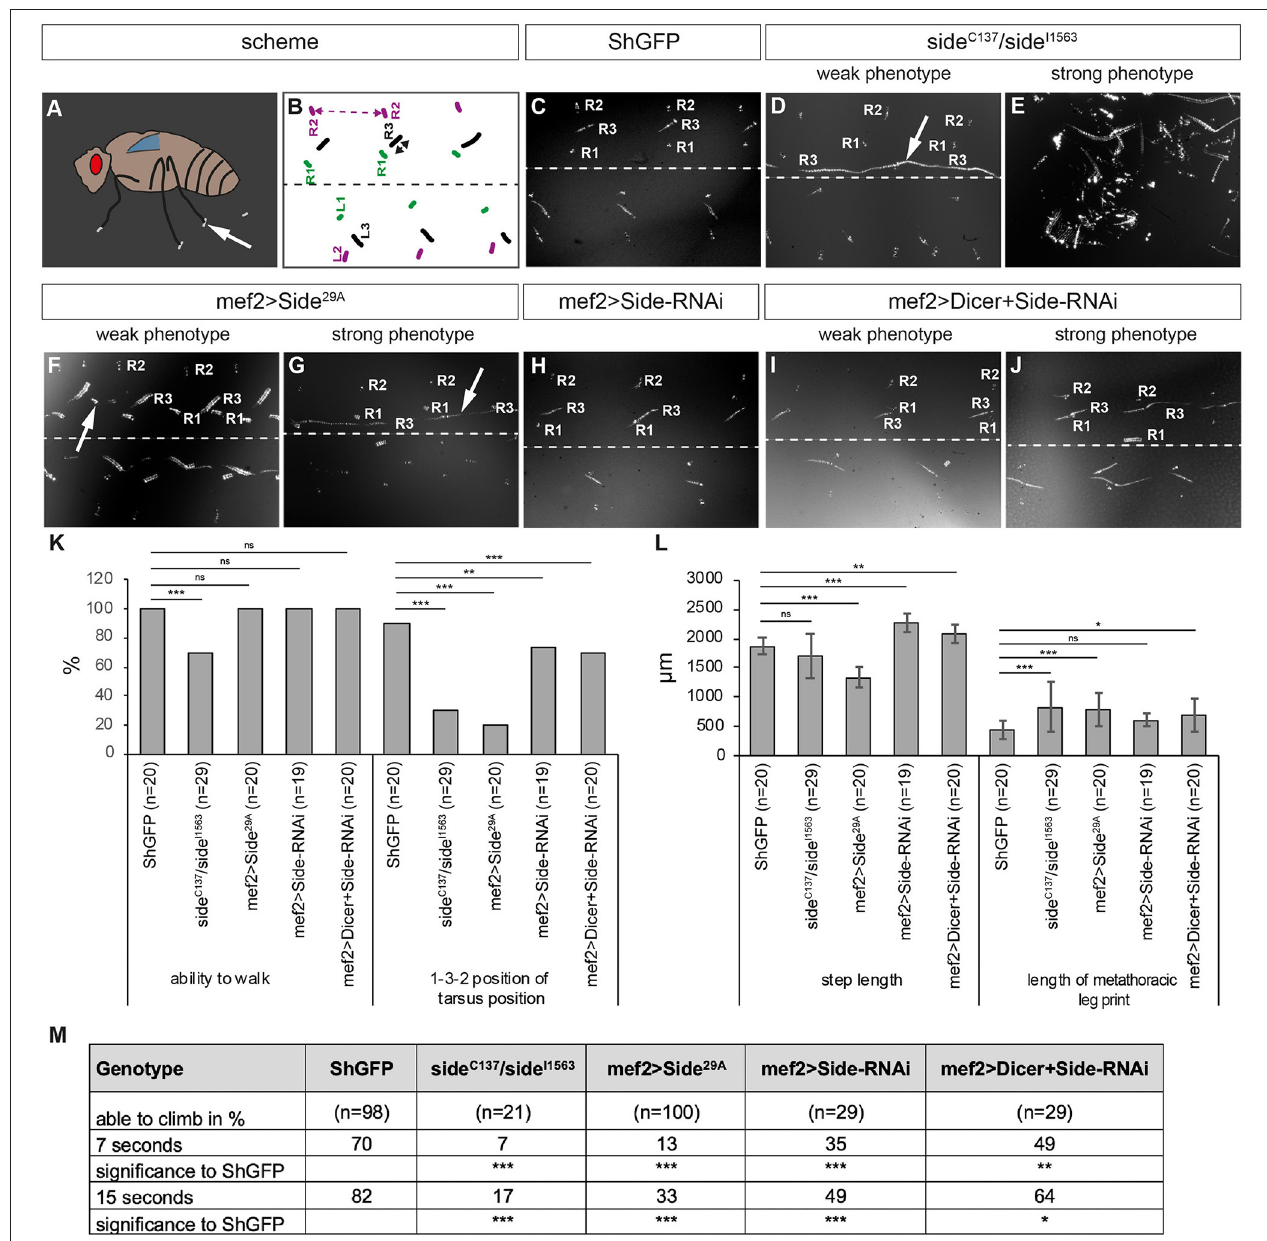
FIGURE 3 | Misinnervation of leg muscles strongly alters walking behaviour. (A) Scheme of leg print assay. Arrow marks a leg print. (B) Scheme of stereotyped foot print patterns (colour-coded, e.g., R1 = right prothoracic leg, green). Dotted line indicates body midline. Stippled double-headed arrow (magenta), step length of mesothoracic leg. Black double-headed arrow, length of metathoracic tarsus print. (C–J) Bright-field images of tarsus prints on carbon soot-coated glass slides. (C) Leg print pattern of ShGFP control flies. Prints of right legs are labelled from medial to lateral: R1, R3, and R2. (D,E) Side mutant walking phenotypes vary from dragging R3 at an unusual inner-most position (weak phenotype, arrow in D ) to being completely unable to walk (strong phenotype, E ). (F,G) Overexpressing Side flies show some minor stumble (weak phenotype, arrow in F ) or more obvious dragging phenotypes (strong phenotype, arrow in G ). (H) Downregulation of Side using RNAi driven by Mef2-Gal4 results in no obvious phenotypes. (I,J) Enhancing RNAi by Dicer leads to clearly visible prolonged prints of the third leg (J) . (K,L) Statistical analysis of leg print assays. (K) Approximately 30% of side mutants ( n = 29) are not able to walk across the glass slide. Both loss and gain of Side function as well the downregulation of Side result in various percentages, in altered successions in the T1-T3-T2 print pattern. (L) Overexpressing Side flies exhibit a shortened step length of the mesothoracic legs (T2-T2), while downregulation of Side using RNAi results in an increased step length compared to controls. (M) Results of the climbing assay. Downregulation, loss, or gain of Side leads to a reduced climbing ability of adult flies compared to controls. Data are total number (K) or means ± SD (L + M) , Fisher exact test (K) , one-way ANOVA (L + M) : *** P < 0.001, ** P < 0.01, * P < 0.5; ns, not significant; n, number of males. Genotypes: w; + ;ShGFP, w; + ;side C 137 , ShGFP/side I 1563 , ShGFP, w; + ;Mef2-Gal4, ShGFP/UAS-Side 29 A , w;UAS-Side-RNAi/ + ;Mef2-Gal4/ + ;w;UAS-Side-RNAi/ + ;Mef2-Gal4/UAS-Dicer.